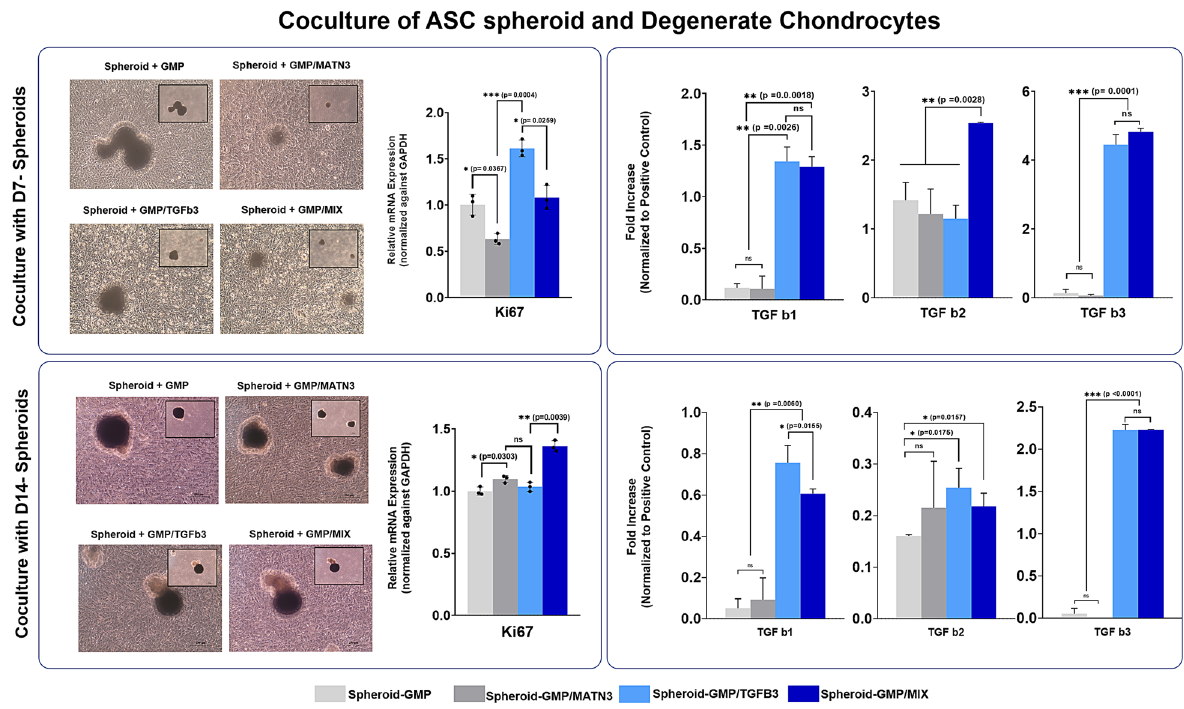
Fig. 7 Coculture of D7- and D14-differentiated hASC spheroids with degenerated chondrocytes. Representative bright- fi eld images of the cocultures of D7-differentiated ASC spheroids (top panel) and D14 differentiated spheroids (bottom panel) with degenerated chondrocytes (scale bars = 200 µm). Quantitative real-time gene expression analysis proliferation marker Ki-67. Quantitative analysis of secreted TGF- β isoforms from hASC spheroids (right panel). RT-PCR data were normalized against GAPDH expression. The data are representative of three independent experiments in triplicate. Error bars denote the means ± standard error of mean (sem) (ns = not signi fi cant, * p < 0.05, ** p < 0.01, *** p < 0.001; **** p < 0.0001). Individual data point and p -values for signi fi cance are indicated in the